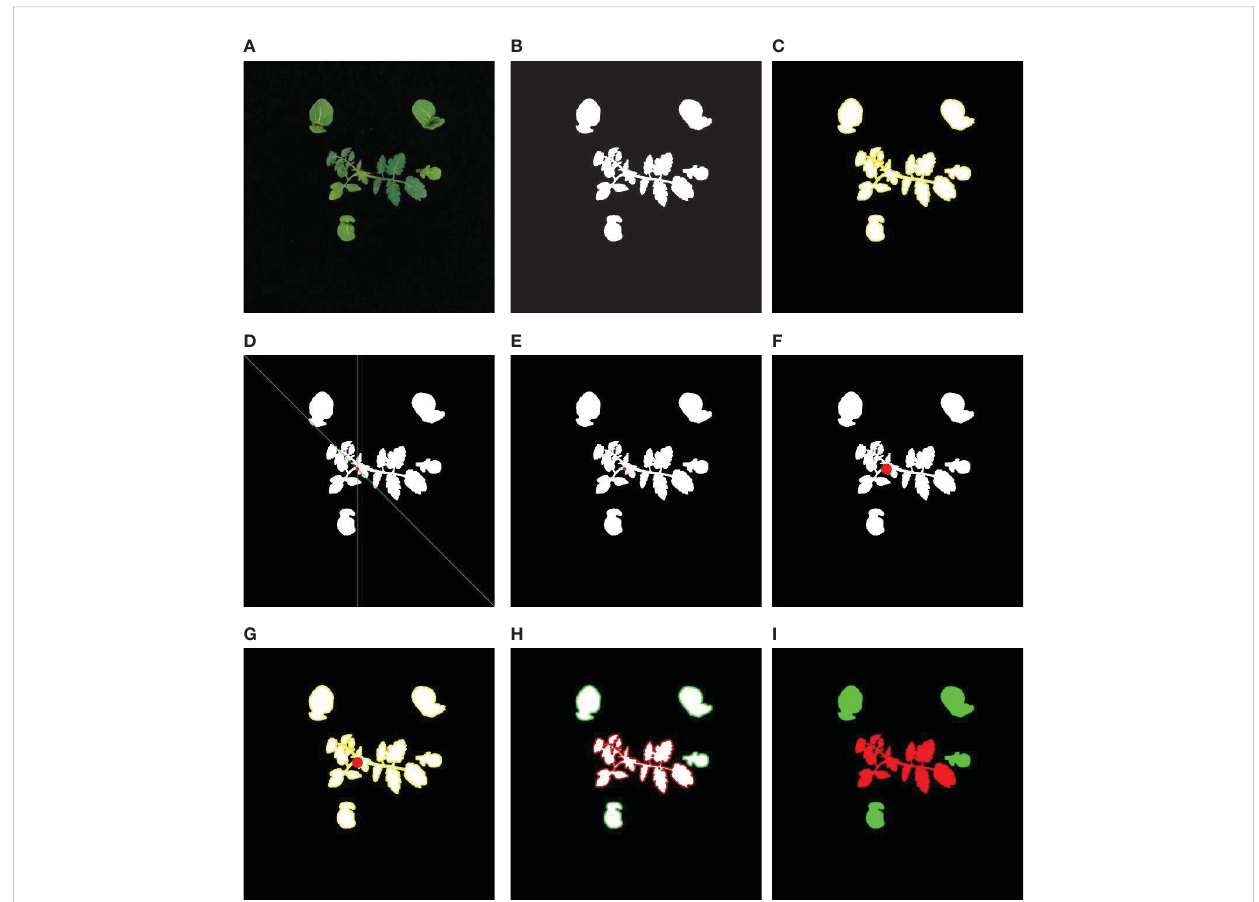
FIGURE 6 (A) Image of tomato plant and weeds captured by the system, (B) binary image after morphological operations, (C) binary image with plants contours (yellow), (D) position of the crop signal in the RGB image, (E) position of crop signal in the binary image, (F) crop signal tolerance bands in the binary image, (G) the contours of plants (yellow) and the crop signal tolerance bands (red) in the binary image, (H) the contours of tomato plant (red) and the contours of weeds (green), (I) pixel mapping of weeds (green) and crop plants